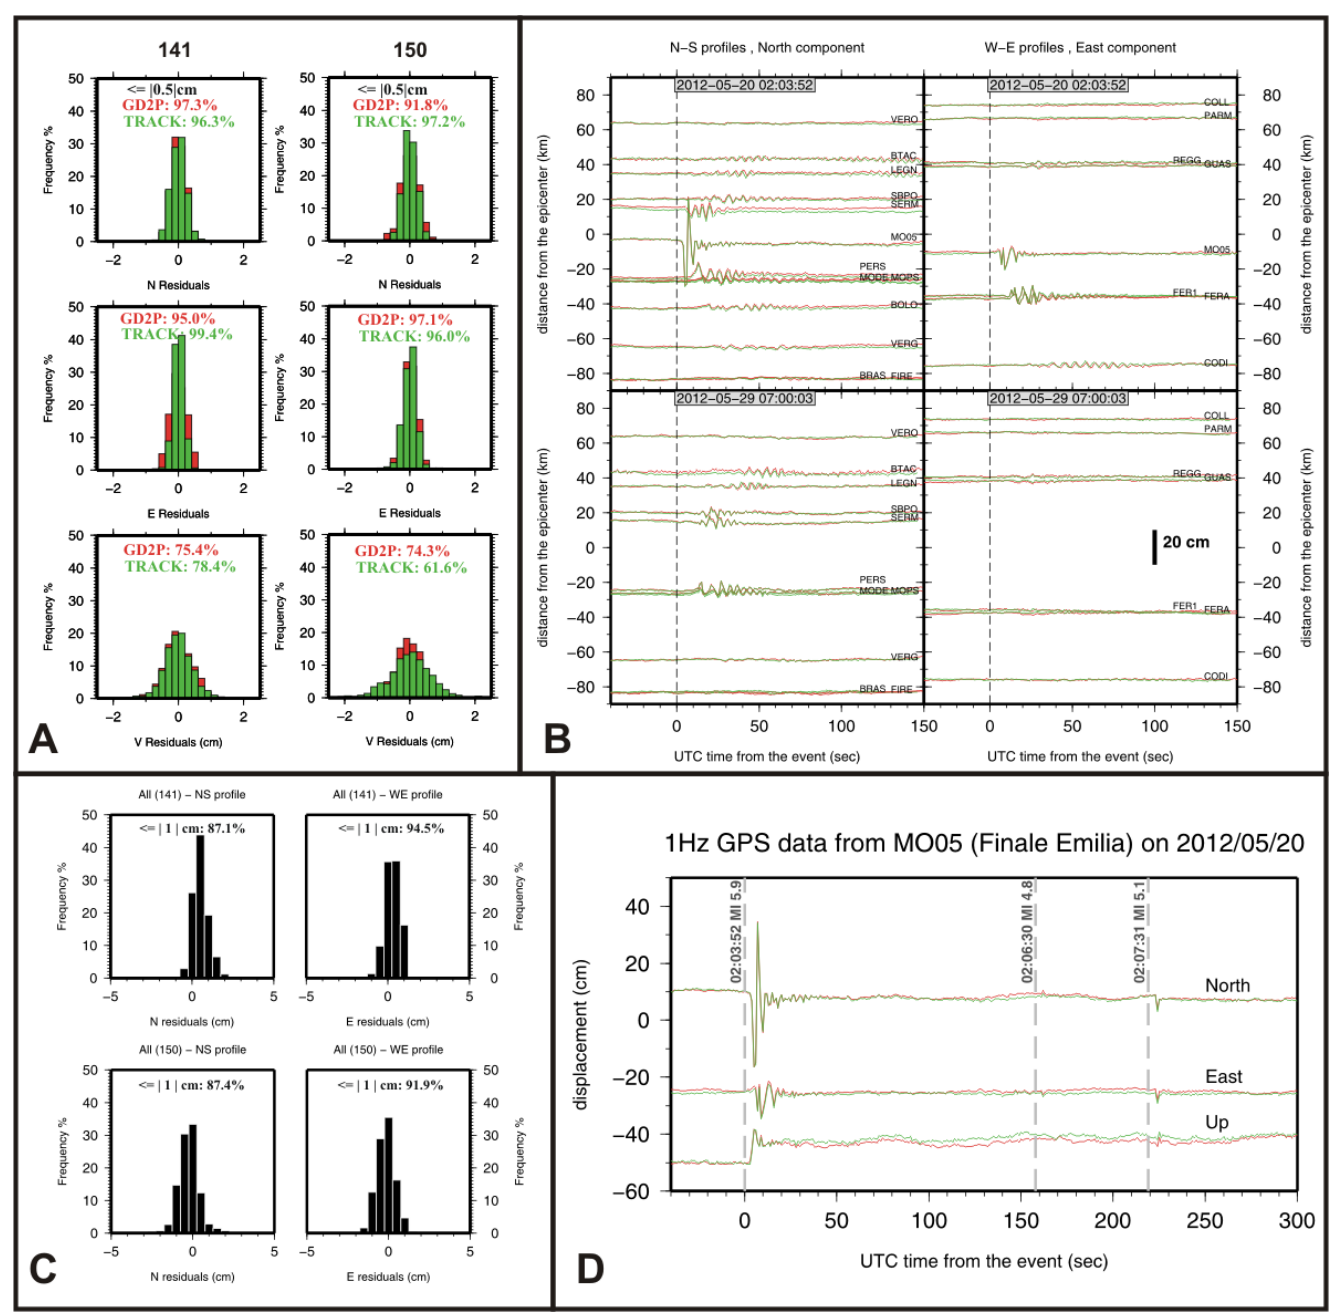
Figure 2. A. Distribution of the residuals of all of the time series in a pre-seismic 40-s time window for GD2P (red) and TRACK (green). B. North (left) and East (right) components of the 1-Hz GD2P (red) and TRACK (green) time series of sites located along the N-S and W-E profiles, respectively, of Figure 1, in a time interval of 190 s spanning the May 20, 2012, M 5.9 (top) and May 29, 2012, M 5.8 earthquakes (bottom). C. Distributions of the resid- L L uals obtained by the epoch-by-epoch difference between the GD2P and TRACK solutions on the North (left) and East (right) components. These his- tograms include the residuals of all of the sites of the two profiles in (B) for the May 20, 2012, event (doy 141, top) and the May 29, 2012, event (doy 150, bottom). D. Detailed comparison between GD2P (red) and TRACK (green) solutions for MO05 of May 20, 2012. The time series spans a time interval of 350 s. Dashed vertical bars, occurrence of the May 20, 2012, mainshock and of the two immediately successive